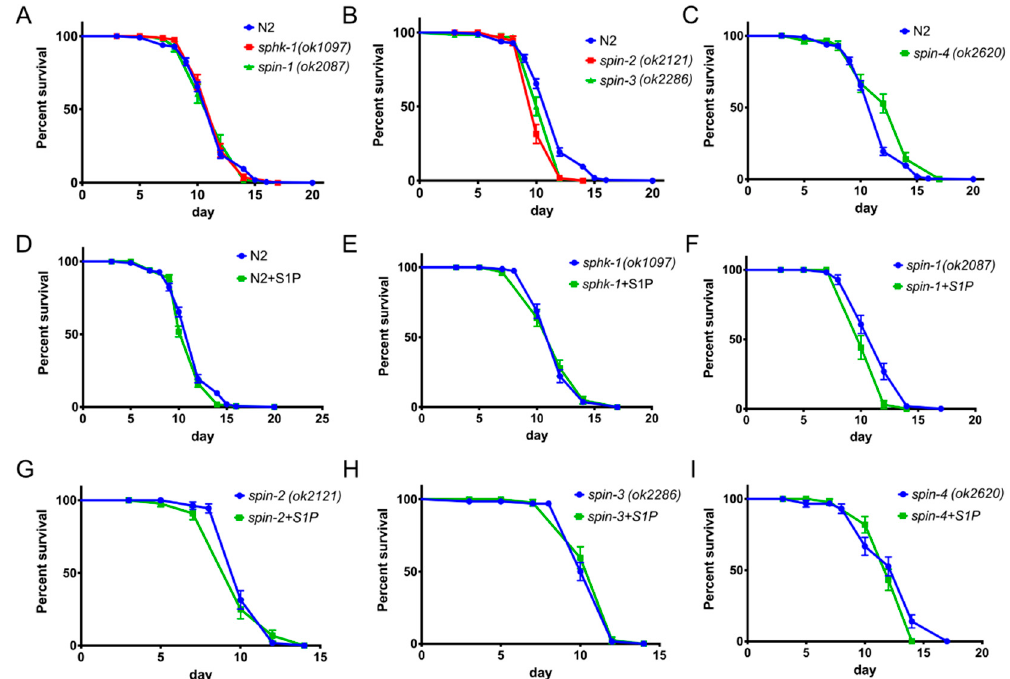
Figure 7. Select S1P transporters affect C. elegans lifespan while S1P supplementation has no affect. Mutant worms showing the same lifespan ( A ), decreased lifespan ( B ), and increased lifespan ( C ) compared to wild type N2. Comparison of the survival with or without S1P in the background of wild type N2 ( D ), sphk-1 ( E ), spin-1 ( F ), spin-2 ( G ), spin-3 ( H ), and spin-4 ( I ). The log-rank (Mantel-Cox) test was used for statistical analysis of worm survival.